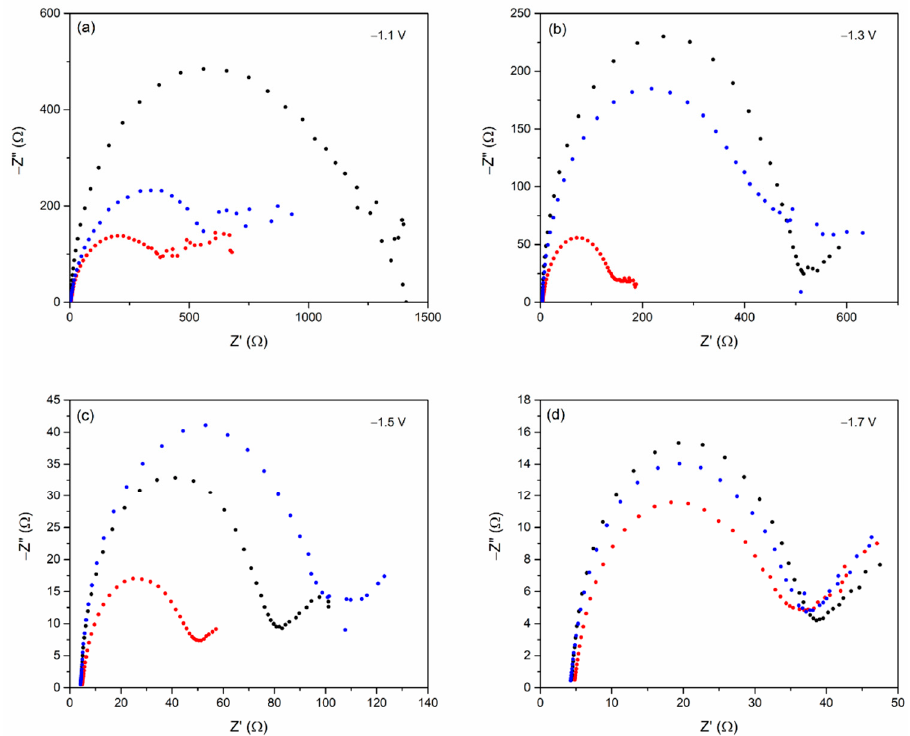
Figure 4. The Nyquist’s plot for 0.1Bi/Sn (black), 0.05Bi/Sn (red), and 0.01Bi/Sn (blue) electrodes at the applied potentials of ( a ) − 1.1 V, ( b ) − 1.3 V, ( c ) − 1.5 V, and ( d ) − 1.7 V vs. Ag/AgCl. Table 1. Charge-transfer resistance (R ct ) of Bi/Sn electrodes analyzed by EIS.